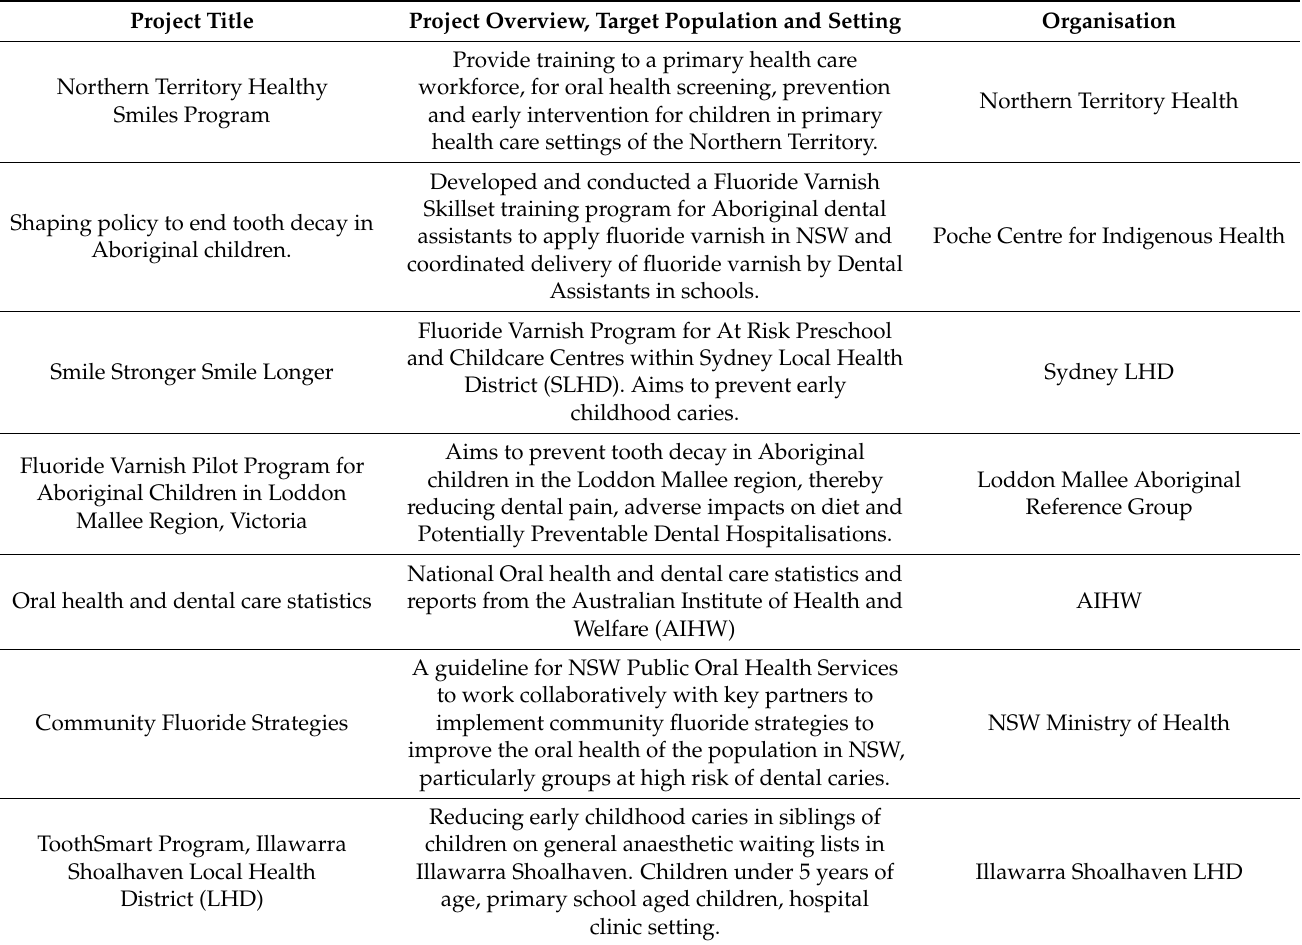
Table 1. Fluoride varnish program involvement by workshop